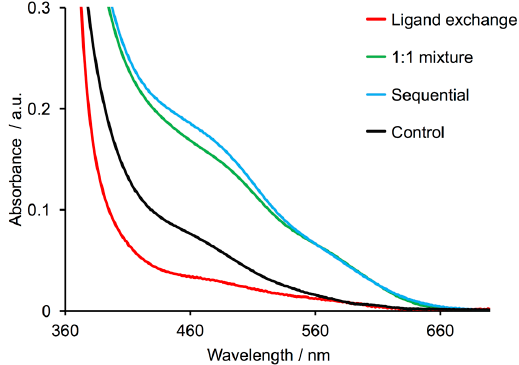
Figure 6. Solid-state absorption spectra of FTO/TiO 2 electrodes functionalized with anchor 3 followed